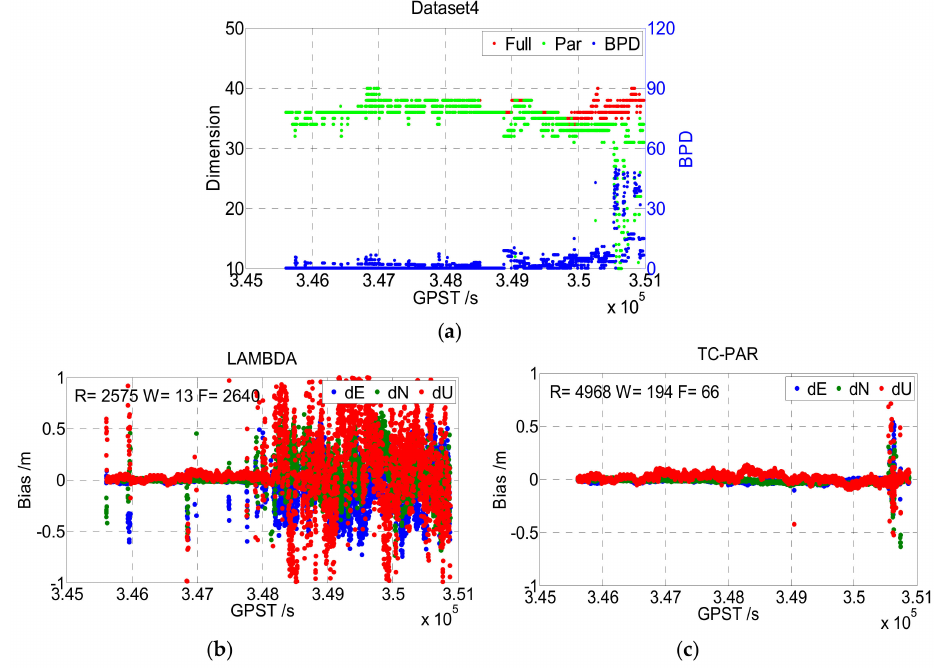
Figure 10. Dimensions of the ambiguity full set / subset and BPD value ( a ) and the baseline deviation sequence of LAMBDA ( b ) and TC-PAR ( c ) in Dataset4. R, W, and F denote the right fixed epoch, wrong fixed epoch, and float epoch,